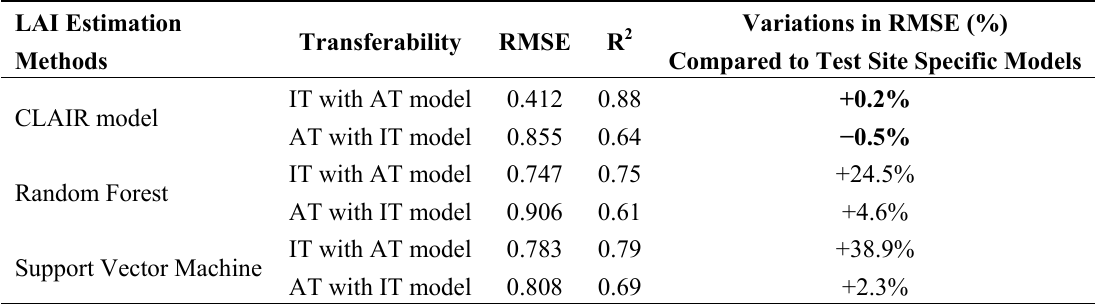
Table 5. Transferability between test sites (IT: Italy; AT: Austria) of the CLAIR model, Random Forest and Support Vector Machine regressions. The parameters of the CLAIR model used in this comparison were derived following the procedure